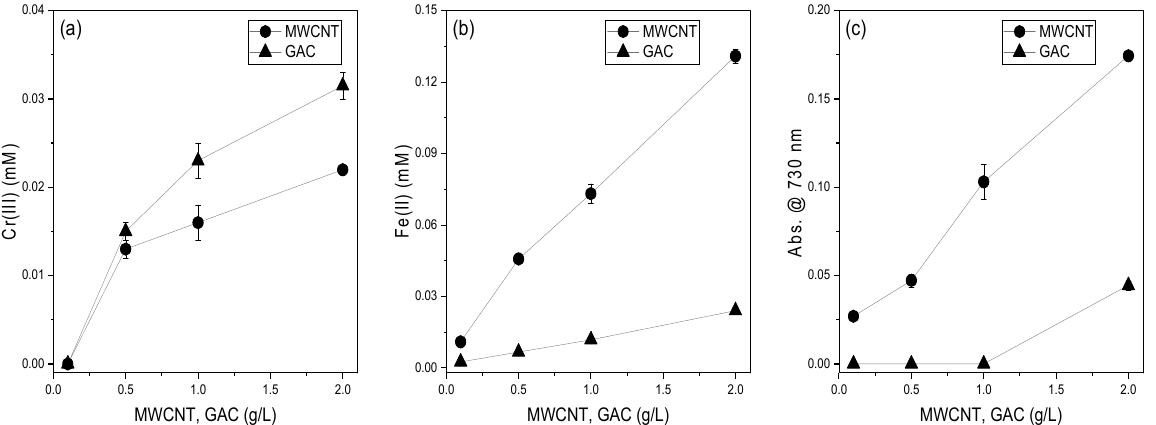
Figure 6. Reduction of ( a ) Cr(VI), ( b ) Fe(III) and ( c ) PMo 12 O 403 − at different dosage of MWCNT and GAC applied ([Cr(VI)] o = [Fe(III)] o = [PMo 12 O 403 − ] o = 0.1 mM, [MWCNT-Comocat] o = [GAC] o = 0.1, 0.5, 1.0, 2.0 g/L, [pH o = 2.5-3], anaerobic condition, [reaction time = 5 min for Fe(III), 60 min for Cr(VI), 120 min for PMo 12 O 403 − ]).